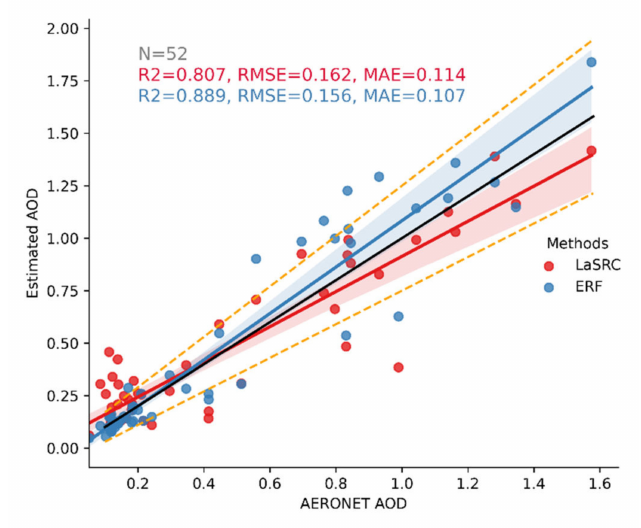
Figure 8. Validation of the 30 m AOD from the ERF model (blue) and the LaSRC algorithm (red) against the AERONET AOD measurements over Beijing. The blue and red solid lines represent the linear regression lines; the blue and red shaded areas represent the confidence interval of regressions. The orange dashed line and the black solid lines represent the MODIS expected error and the 1:1 line, respectively.